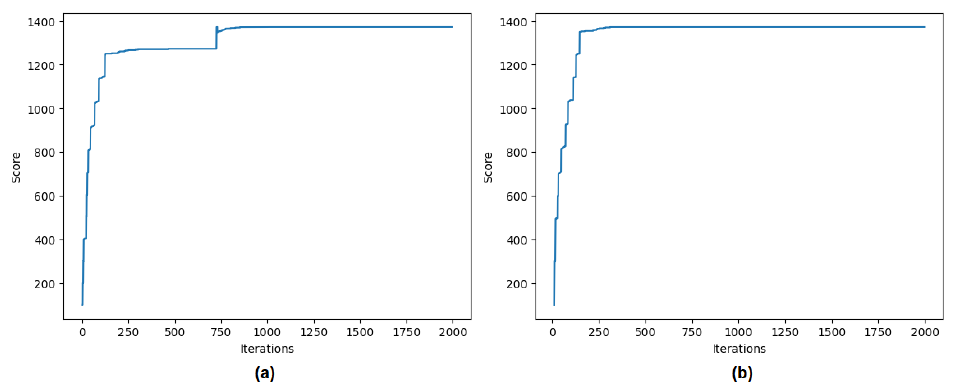
Figure 23. Simulation results: Iterations vs. Score. ( a ) No human, ( b ) Human.